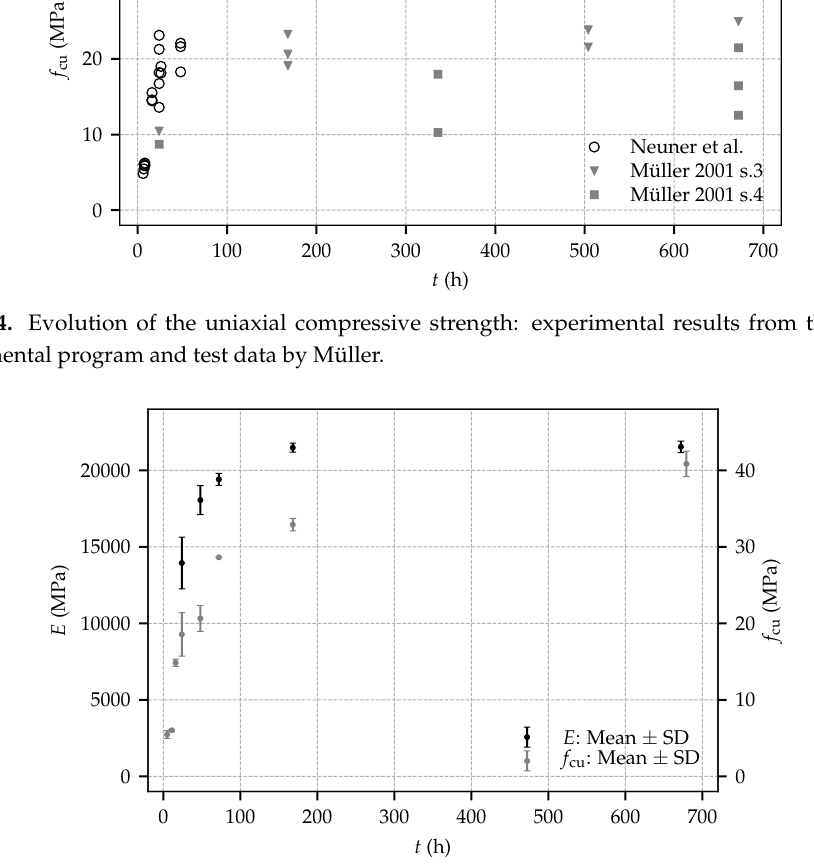
Figure 5. Mean values and standard deviations (SD) of the Young’s modulus and the uniaxial compressive strength for the present experimental